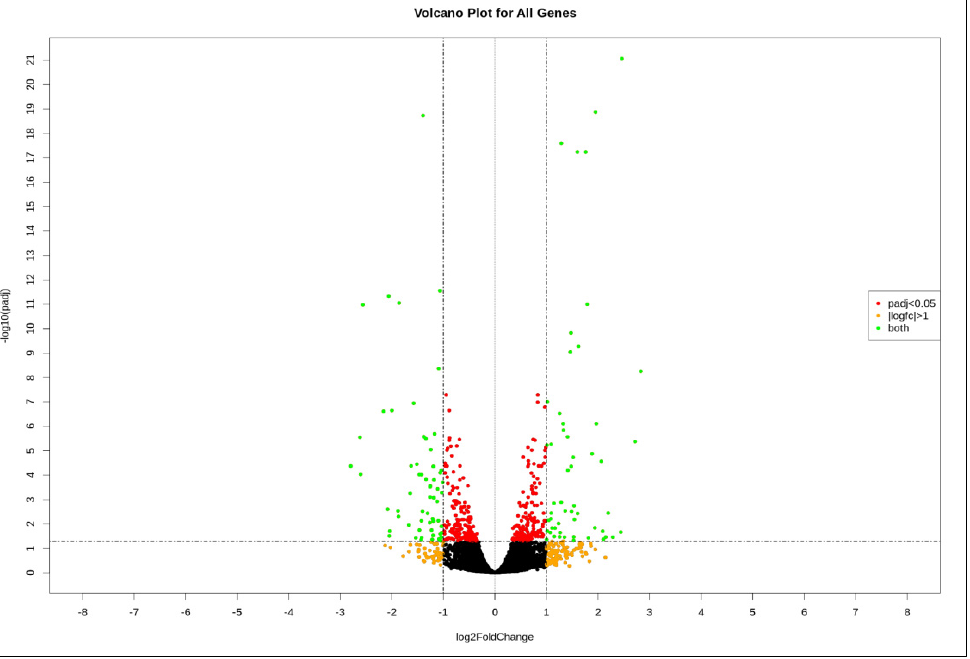
Figure 1. The volcano plot above shows the distribution of all the DEGs identified in this study. Each dot represents a single gene. Green dots are significant genes with p − adj < 0.01 and |log2 fold change| > 1 (equivalent to a fold change of magnitude greater than 2).